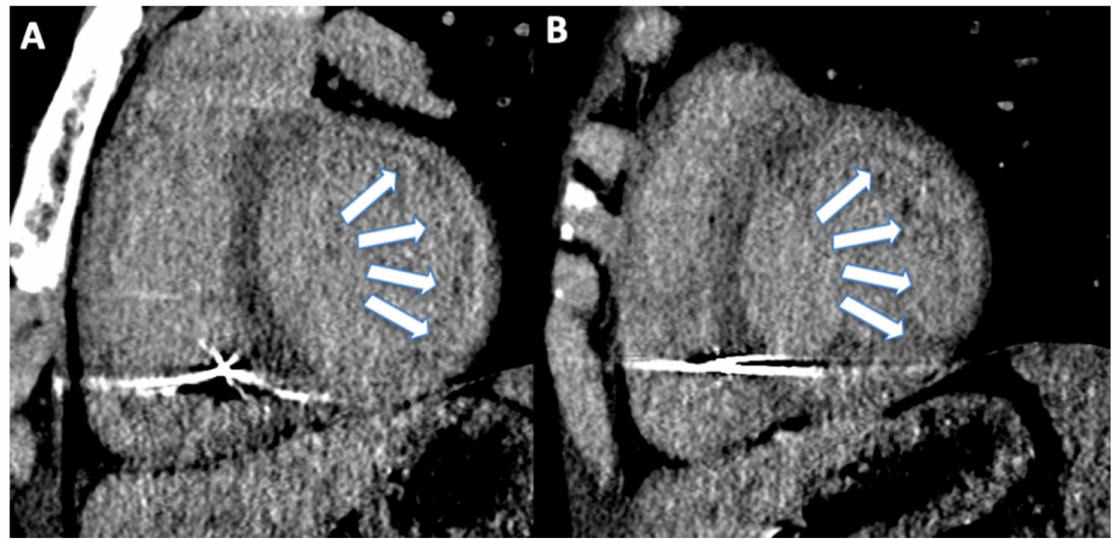
Figure 6. ( A ) 23 year old male patient with history of cardiac arrest. After the implantation of im- plantable cardioverter defibrillator, the patient acquired cardiac computed tomography angiography for the assessment of late iodine enhancement. Late iodine enhancement reconstructed on short axis showed intramyocardial late iodine enhancement on anterior, lateral, and inferior wall of basal (arrows, ( A )) and mid-ventricular (arrows, ( B )) left